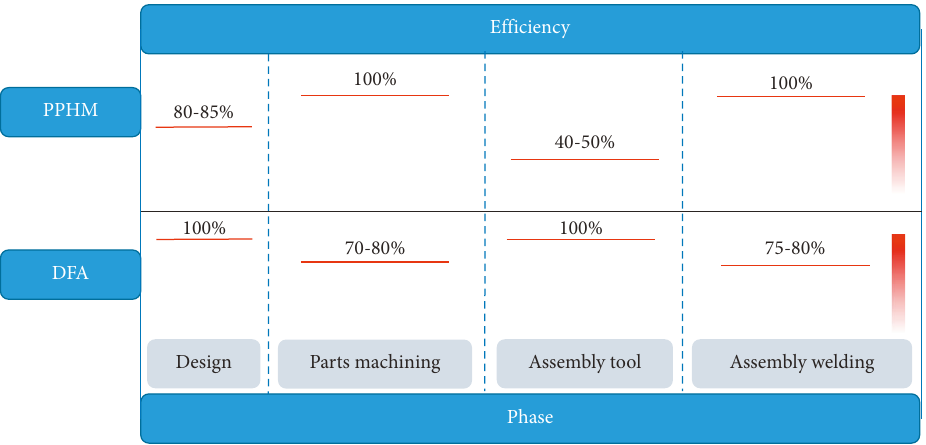
Figure 7: The efficiencies of the two assembly methods (experience-based reference